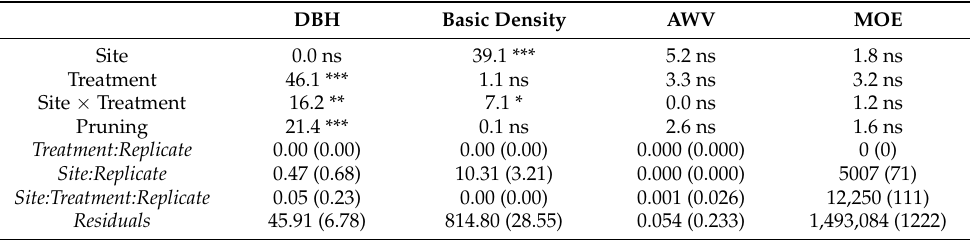
Table 5. Statistics for commercial thinning (EC300) and (EC500) vs. control treatment across two sites of the Eucalyptus nitens thinning trials. Results are F-tests for fixed effects and variance with standard deviation in parentheses for the random effects. Random effects are denoted in italics. Pruning was considered as a co-variate and was not included in the interaction